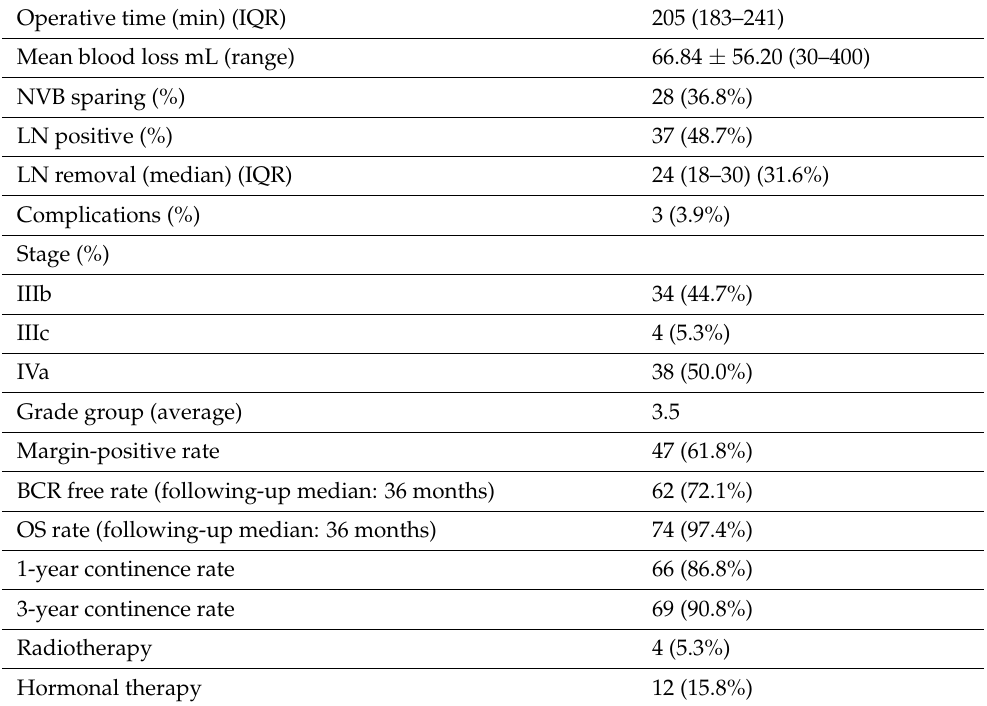
Table 2. Perioperative outcomes for patients with locally advanced prostate cancer.